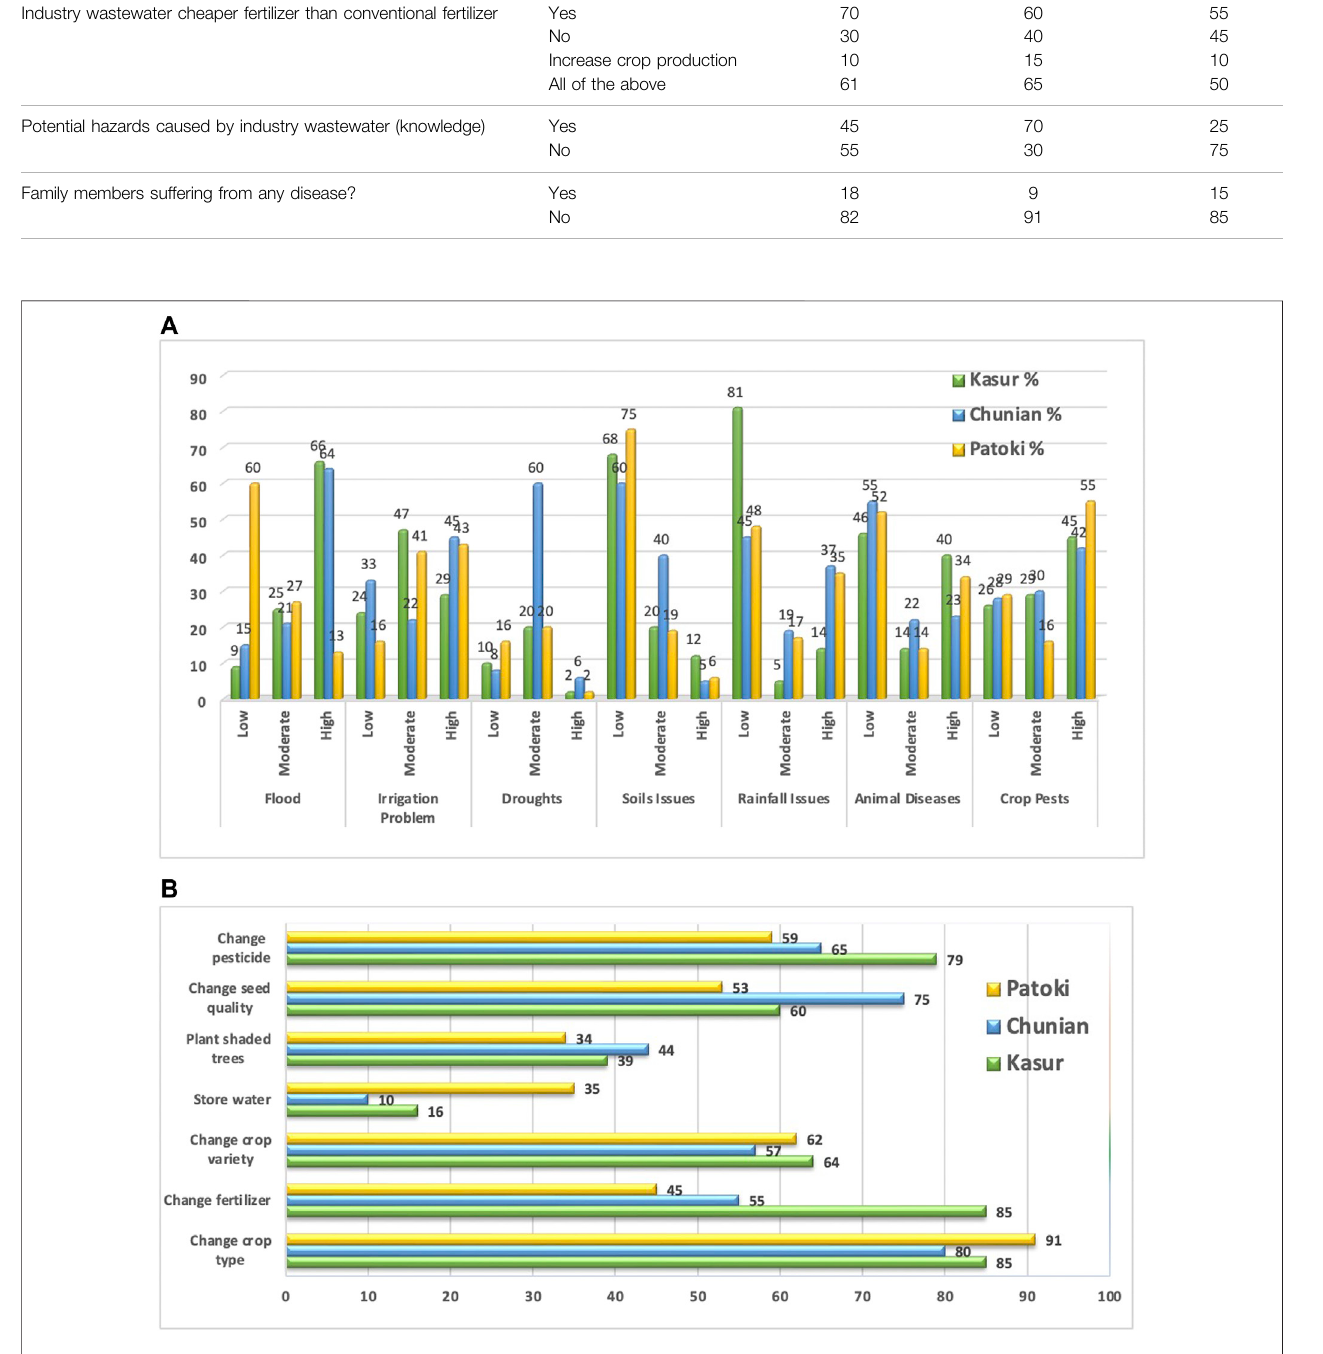
Frontiers in Environmental Science |